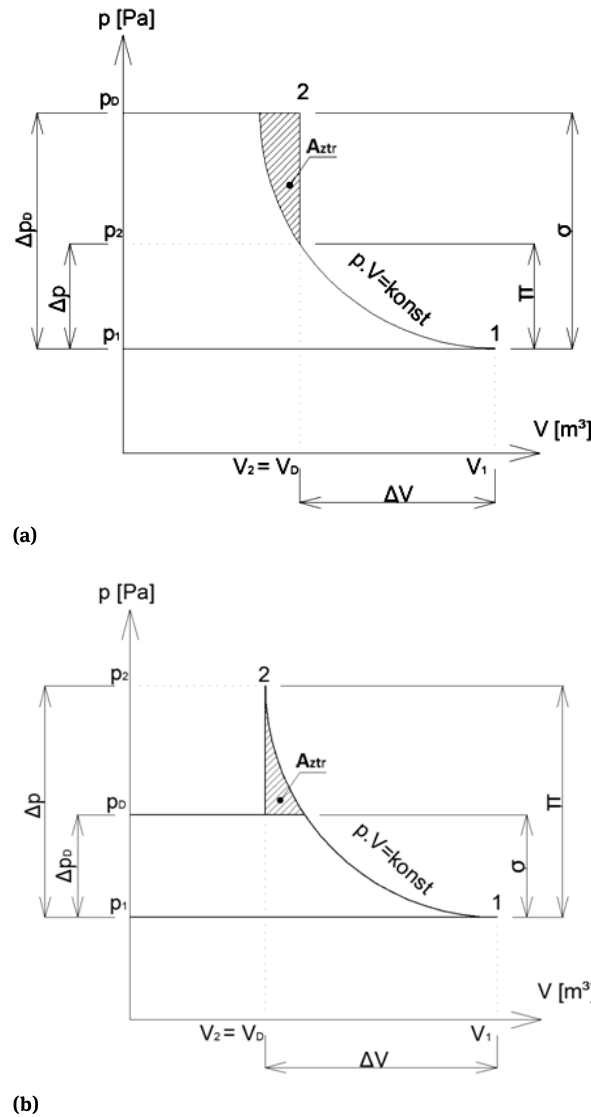
Figure 1: Ideal indicator p-V diagram of shock compression (a) and shock expansion (b)